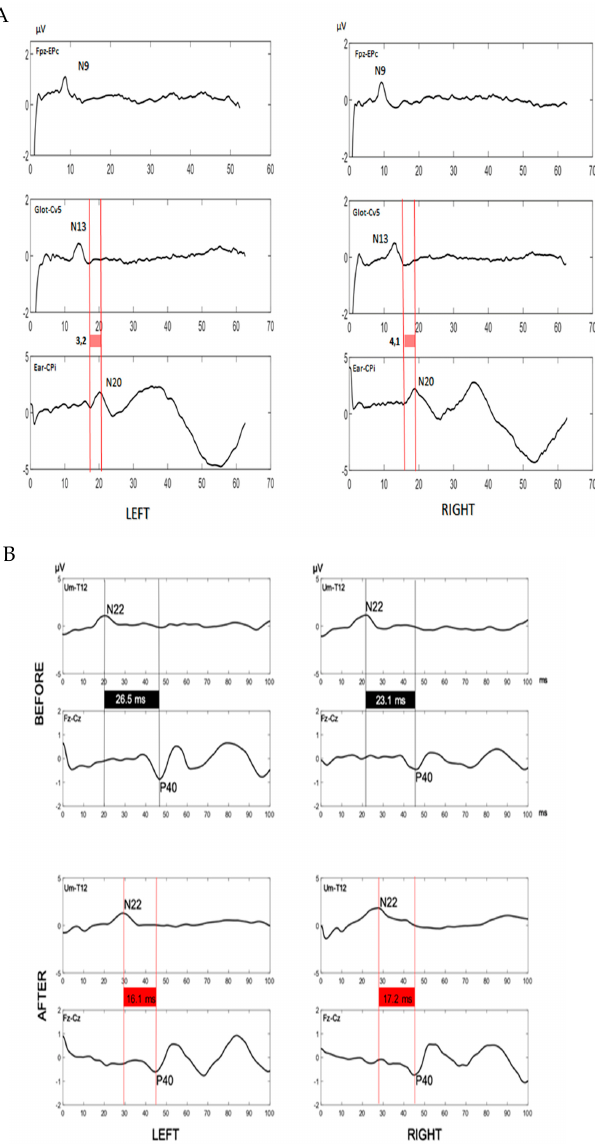
Figure 2. Somatosensory evoked potentials . ( A ). Somatosensory evoked potentials of upper limbs. Central conduction time upper limit in our laboratory: 6.2 ms. N9: brachial plexus somatosensory potential (upper limit in our laboratory: 11.6 ms). N13: spinal somatosensory potential (upper limit in our laboratory: 15.8 ms). N20: cortical somatosensory potential (upper limit in our laboratory: 21.6 ms). Fpz: forehead recording scalp electrode. Epc: Erb’s point dermal electrode. Glot: glottis dermal electrode. Cv5: spine of fifth cervical vertebra dermal electrode. Ear: auricular dermal electrode. CPi: centroparietal recording scalp electrode. All values were within the normal range before and after immunosuppressive therapy. ( B ). Somatosensory evoked potentials of lower limbs before and after corticosteroids. Somatosensory evoked potentials traces were displayed for left and right lower limbs. Please note the pathological values of the central conduction time (black boxes) before corticosteroids (upper traces) and their reduction and normalization (red boxes) after corticosteroids (lower traces). Furthermore, N22 latencies are normal before and pathological after corticosteroids. These data suggest that the dorsal column damage precedes the development of peripheral neuropathy and regress after immunomodulatory therapy. Central conduction time upper limit in our laboratory: 21.3 ms. N22 upper limit in our laboratory: 25.8 ms. N22: spinal somatosensory potential. P40: cortical somatosensory potential. Um: umbilicus dermal electrode. T12: spine of 12nd thoracic vertebra dermal electrode. Fz: fronto-median recording scalp electrode. Cz: centro-median recording scalp